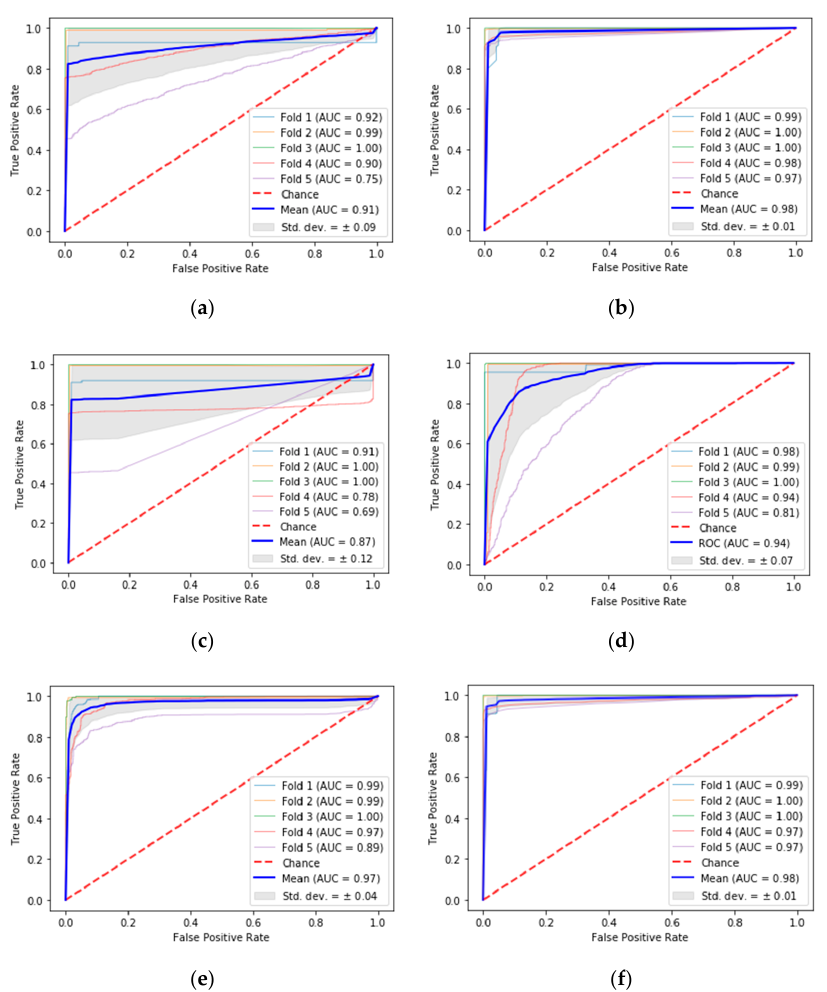
Figure 5. ROC analysis: ( a ) logistic regression; ( b ) random forest; ( c ) multi-layer perceptron; ( d ) one- Figure5. ROCanalysis: ( a )logisticregression; ( b )randomforest; ( c )multi-layerperceptron; ( d )one-class class SVM; ( e ) long short-term memory; ( f ) deep reinforcement learning. SVM; ( e ) long short-term memory; ( f ) deep reinforcement